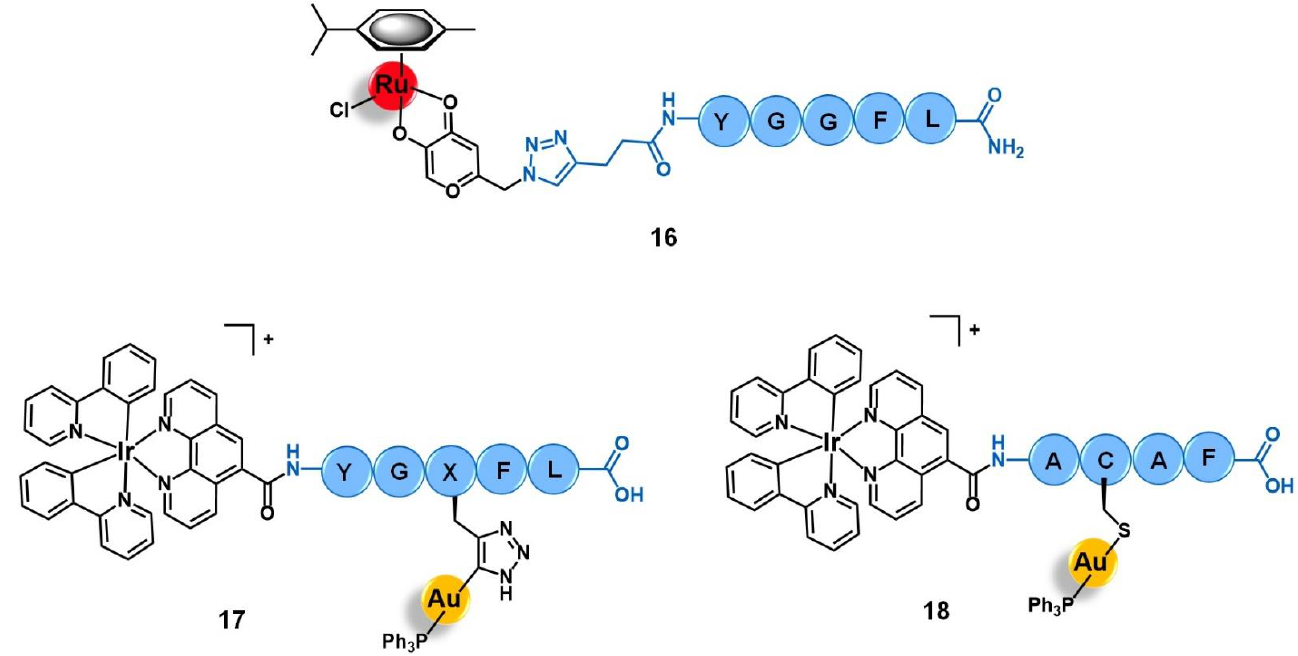
Figure 7. Ru(II)- and Au(I)-conjugates containing an enkephalin analogue ( 16 and 17 ) or a specific short-peptide ( 18 ) for targeting the opioid receptors (OPR). Note: X = propyrgyl-glycine.